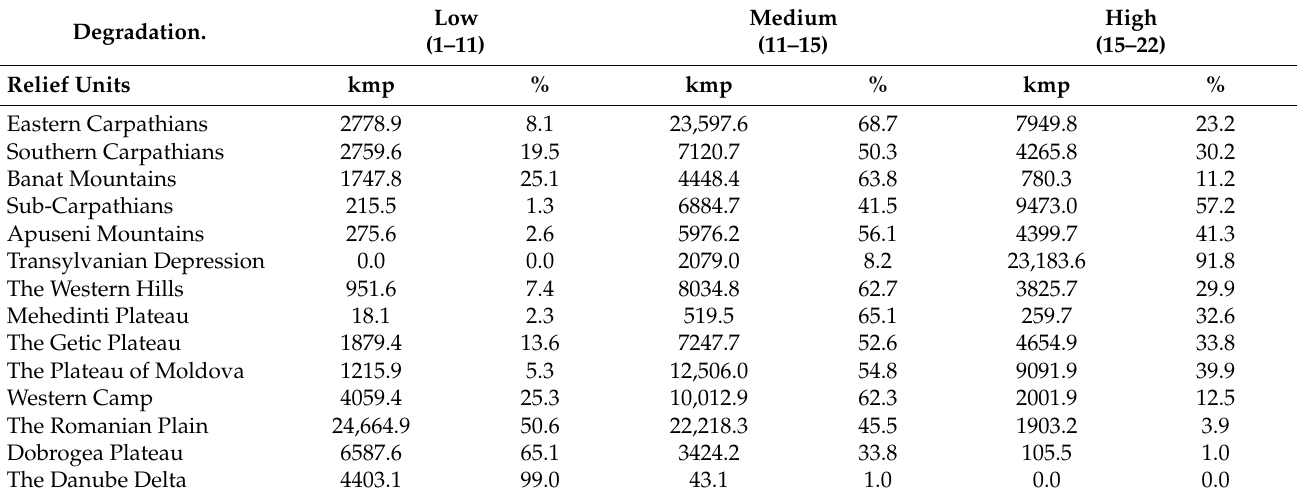
Table 3. Classification of relief units in Romania by degradation classes.